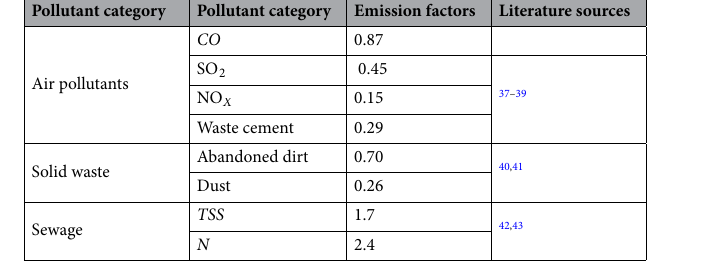
Table 3. List of pollutant emission factors 37–43 .